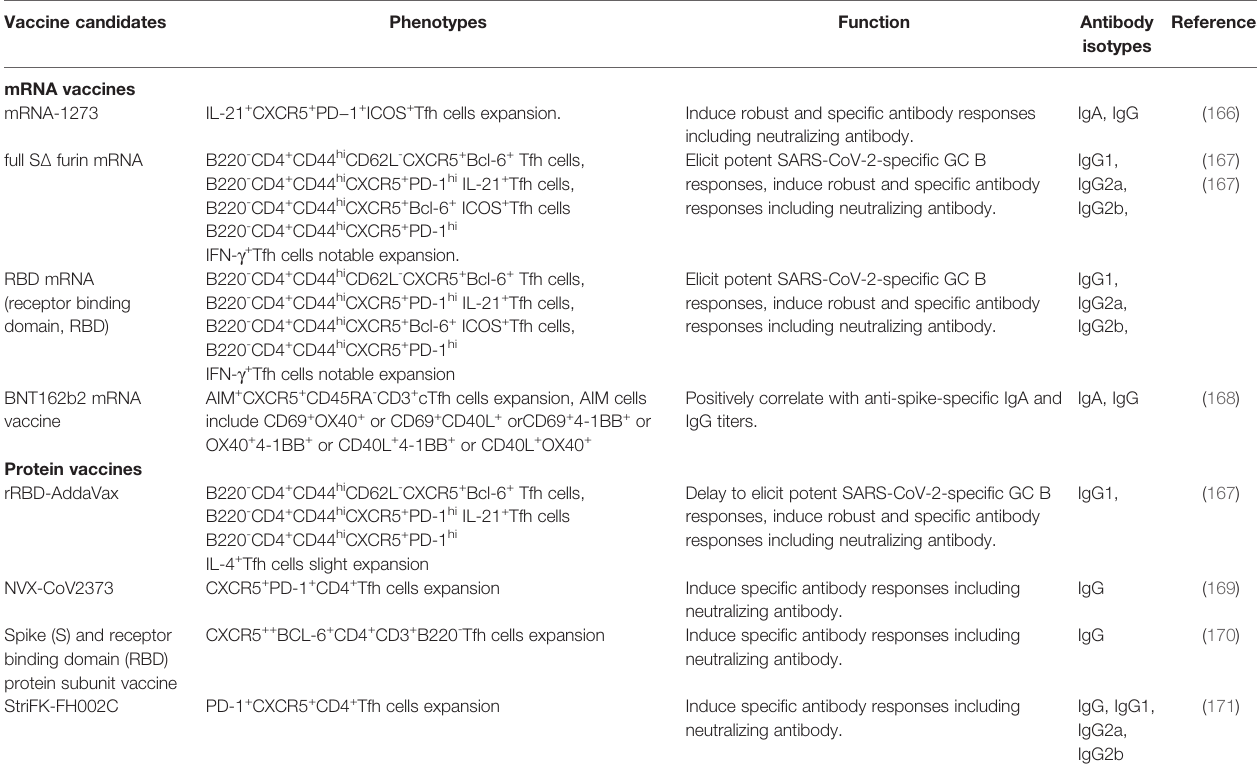
TABLE 3 | Tfh cell responses in various vaccine candidates of